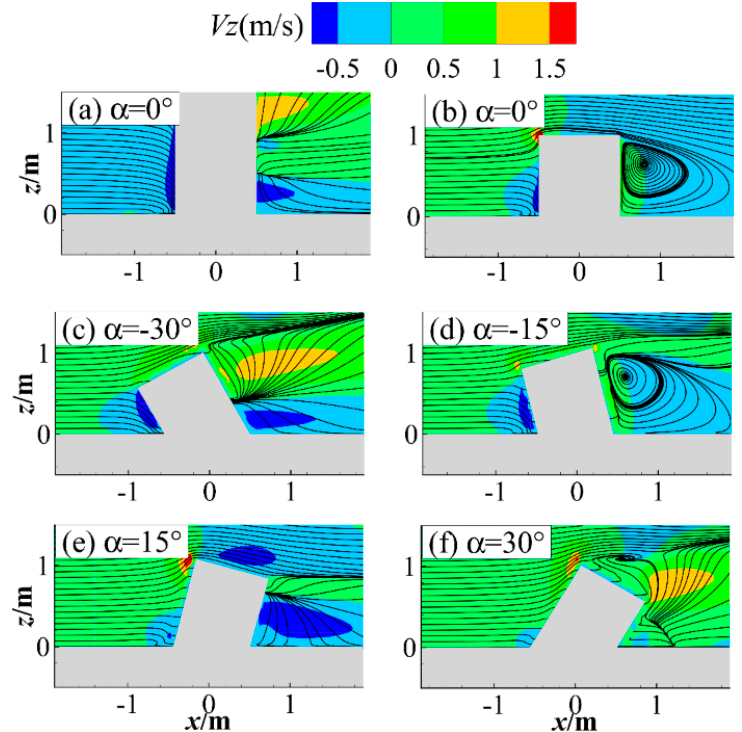
Figure 8. The contour of vertical velocity Vz and streamlines around the cylinder in symmetry plane ( y = 0 m) at t = 0 s, ( a – f ) represents Case 1 to Case 6 in Table 2, respectively.